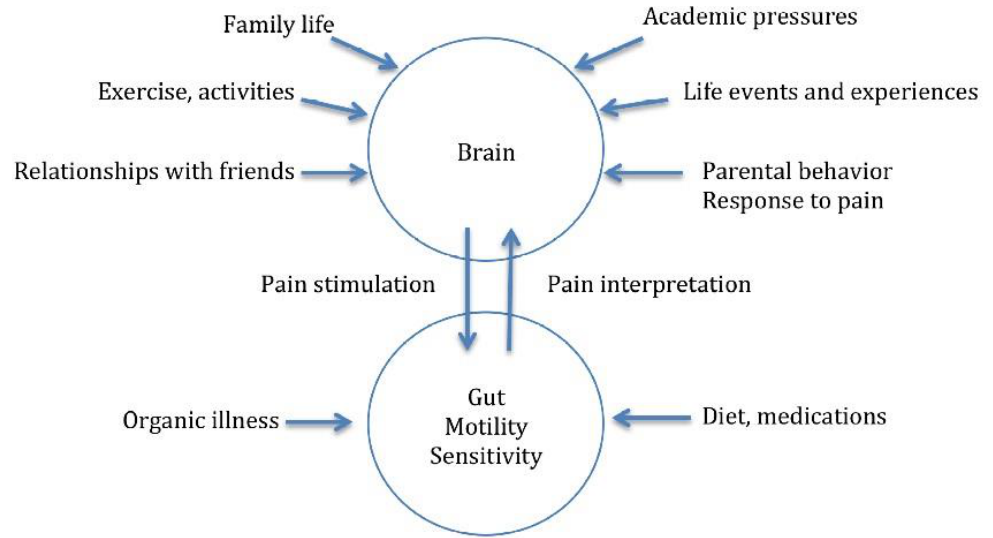
Figure 2. Visual representation of the biopsychosocial model in the context of pediatric functional abdominal pain. Adapted from Brown, L.K.; Beattie, R.M.; Tighe, M.P. Practical management of functional abdominal pain in children [35].